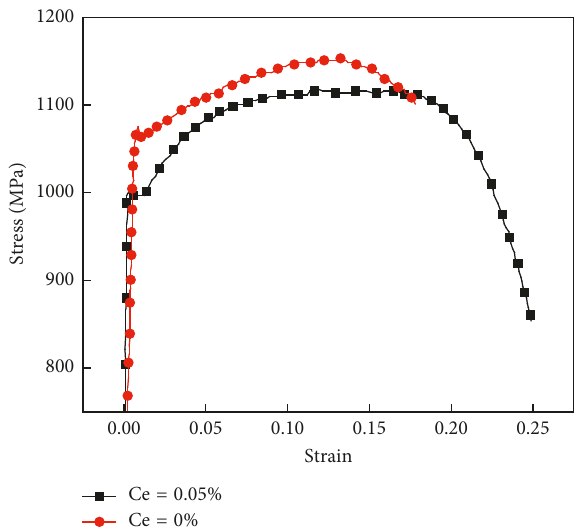
Figure 6: Hardening curves in tensile tests with the content of rare earth Ce.